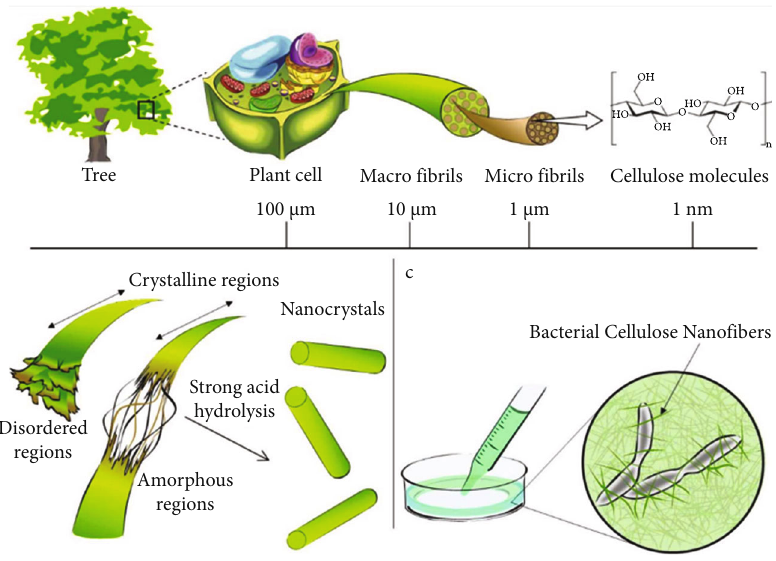
Figure 1: Traditional technique in synthesizing nanocellulose in the form of crystals